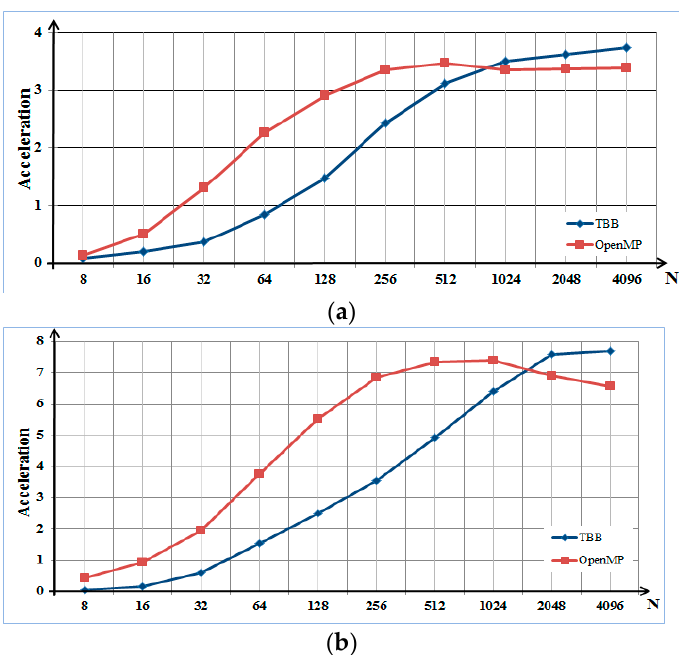
Figure 2. Acceleration results for ( a ) four- and ( b ) eight-core processors.